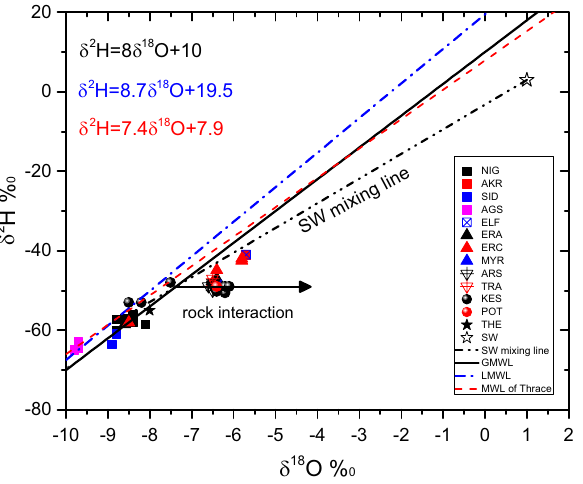
Figure 6. δ 18 O versus δ 2 H of the thermal waters for all studied areas. The black solid line is the Global Meteoric Water Line, The blue dash-dot line is the Local Meteoric Water Line (δ 2 H = (8.7 ± 0.44)*δ 18 Ο + 19.5 ± 3.1) and the red dash line is the Meteoric Water Line of Thrace (δ 2 H = (7.39 ± 0.37)*δ 18 Ο + 7.9 ±